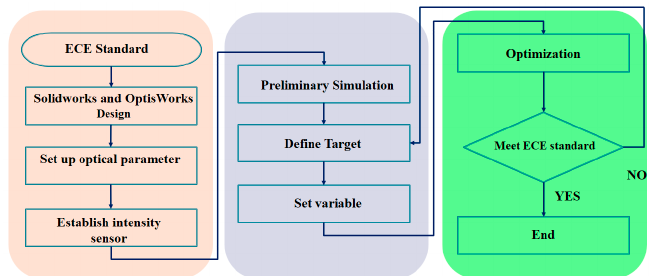
Figure 16. Flow chart of optimization process.